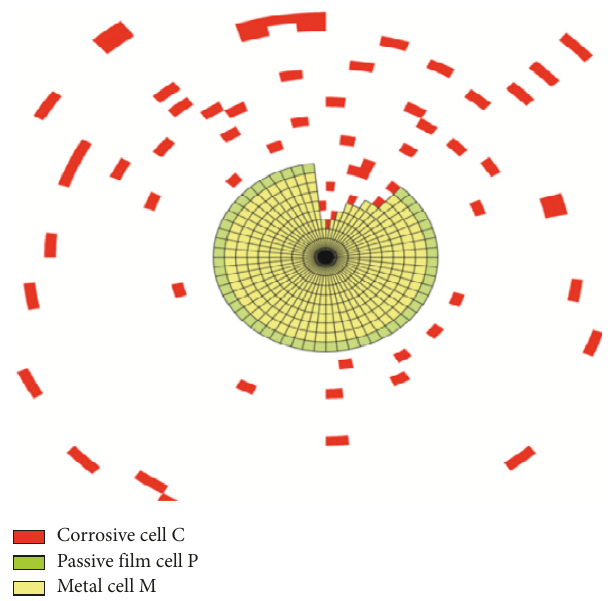
Figure 3: Types of cells in the CA model for the corrosion process of high-strength steel